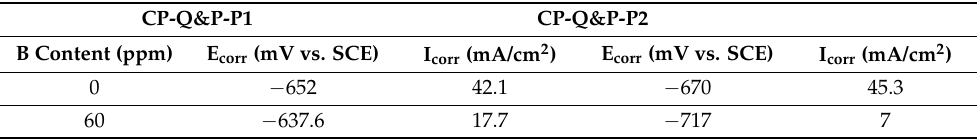
Figure 17. Polarization curves of the complex phase (CP) steel heat-treated by quenching and partitioning (Q&P) process: ( a ) boron-free steel with P1 and P2 steps, ( b ) boron-containing steel with P1 and P2 steps, and ( c ) influence of the concentration of B in the corrosion resistance of the CP-Q&P steels for P1 and P2 conditions. Table 3. Characteristic parameters of the obtained polarization curves for CP-Q&P